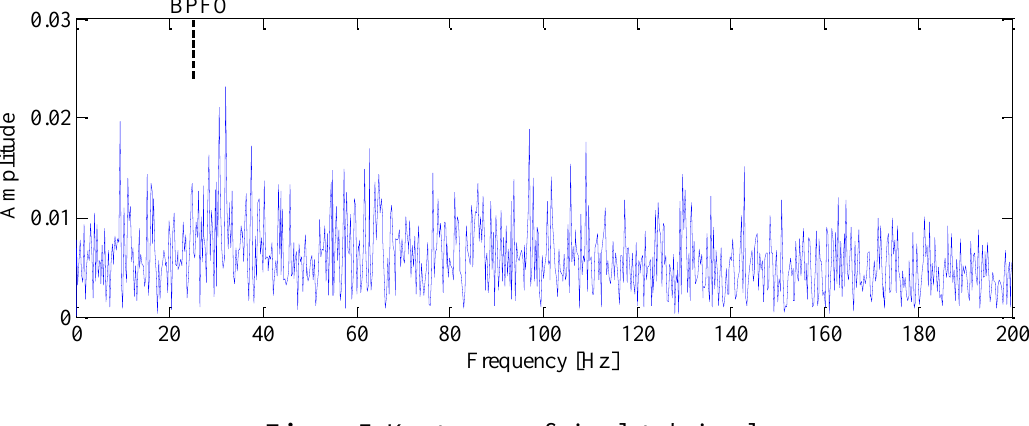
Figure 5. Kurtogram of simulated signal.